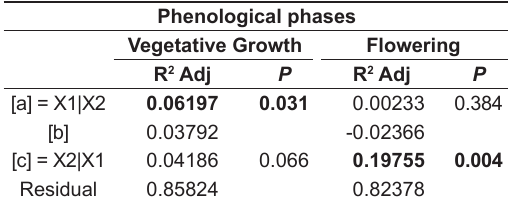
Table 2. Variance partitioning showing the